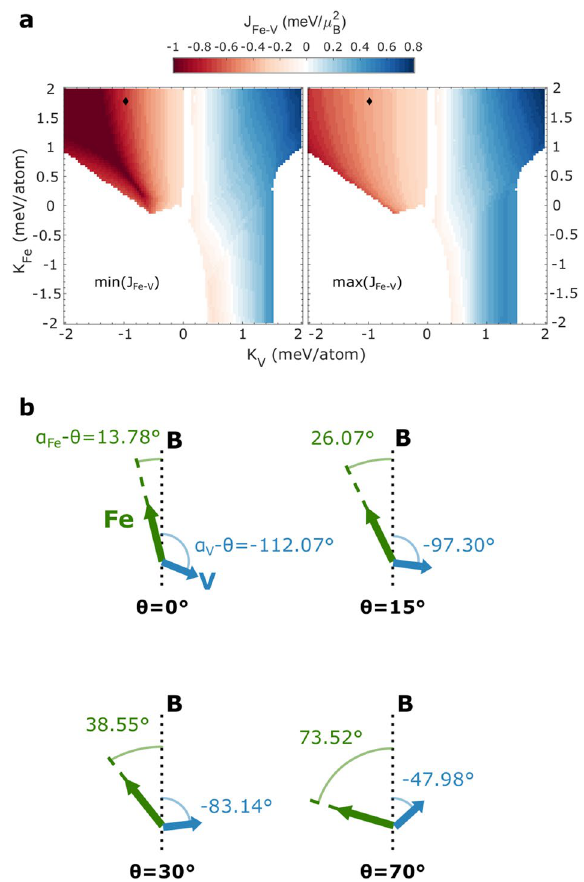
Figure 5. ( a ) Combinations of J Fe-V , K Fe uni and K V uni which allow a spin-flop phase at a magnetic field strength of 7 T and magnetic moments of 2.27 µ B and 0.99 µ B for Fe and V respectively. For every pair of K V uni and K Fe uni , all nonzero values of J Fe-V between the lower bound min( J Fe-V ) (left) and the upper bound max( J Fe-V ) (right) produce a noncollinear arrangement. The black diamond indicates the best fit to the observed XMCD height ratios. These are J Fe-V = -0.575 ± 0.005 meV/ µ 2 B , K Fe uni = 1.80 ± 0.01 meV/atom and K V uni = -0.97 ± 0.01 meV/atom. ( b ) Lowest energy orientations of the magnetic moments relative to the magnetic field, corresponding to the values indicated by the diamond in ( a ) for the four incidence angles used in this